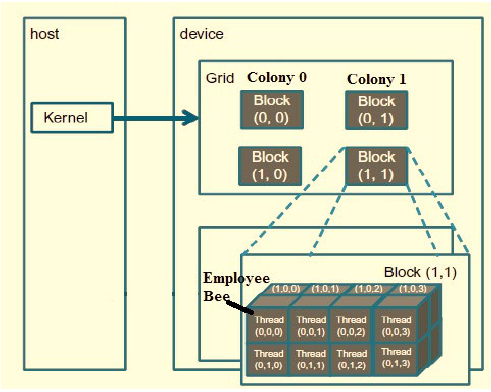
Figure 2. Execution of multi-hive ABC on GPGPU’s